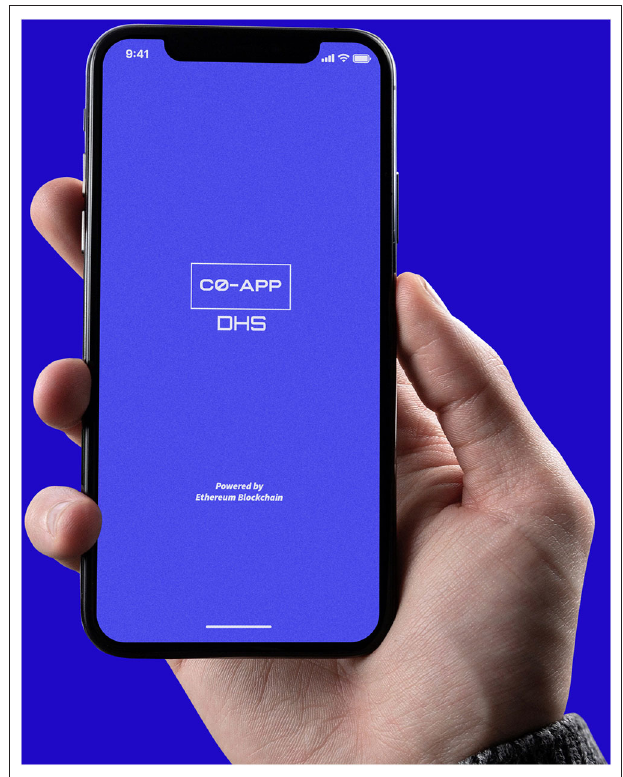
FIGURE 1 | CO-App Digital Health Solution (DHS), a private-permissioned blockchain application powered by the Ethereum